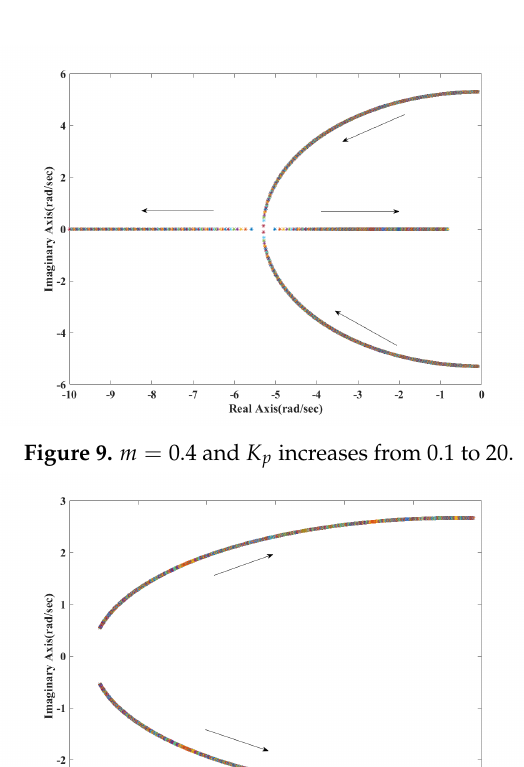
= V ∗ = 600 V, dc ,1 dc ,2